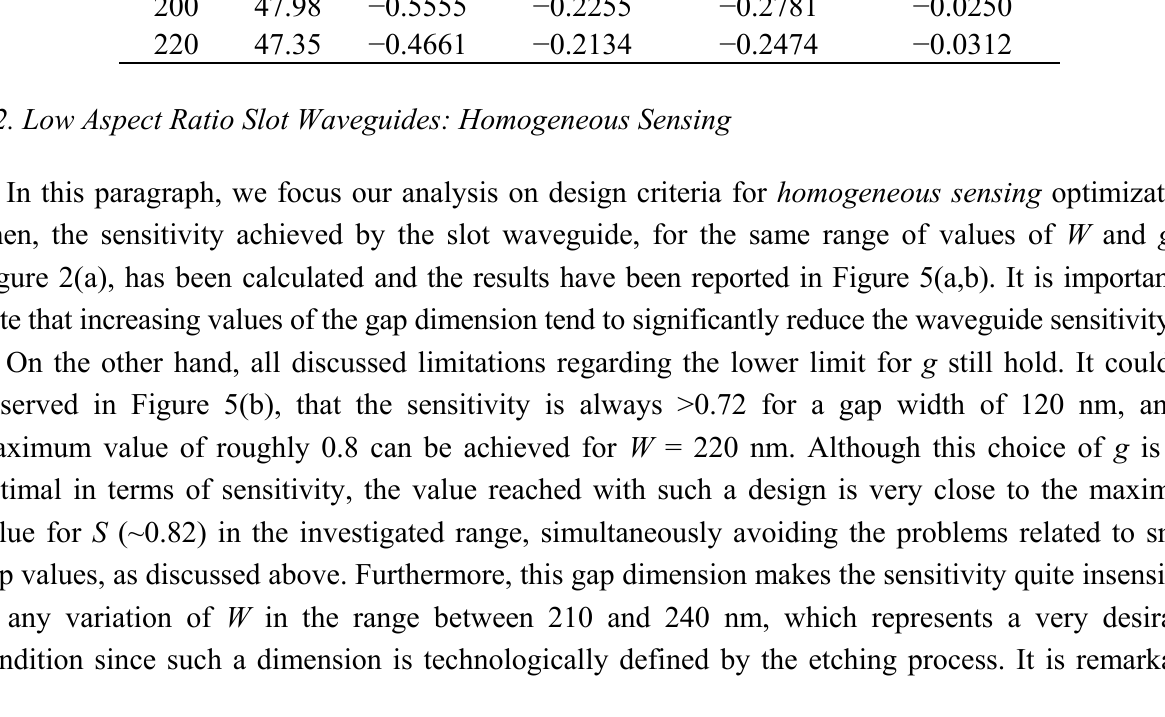
for several technological parameters in c